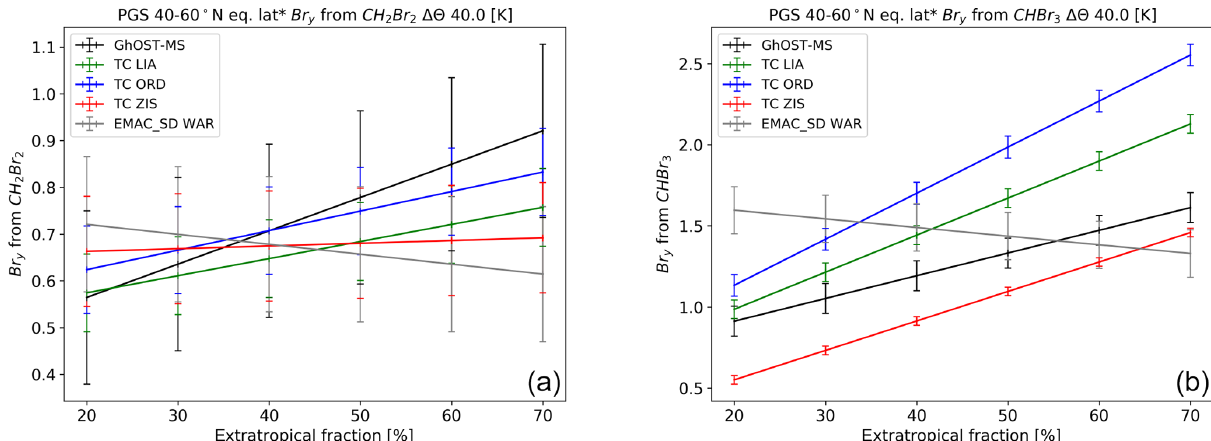
Figure 15. Sensitivity of Br y from CH 2 Br 2 and CHBr 3 at (cid:49)θ = 40K as a function of the fraction of extratropical air for the PGS campaign from January to April 2016 for observations in comparison to the different model